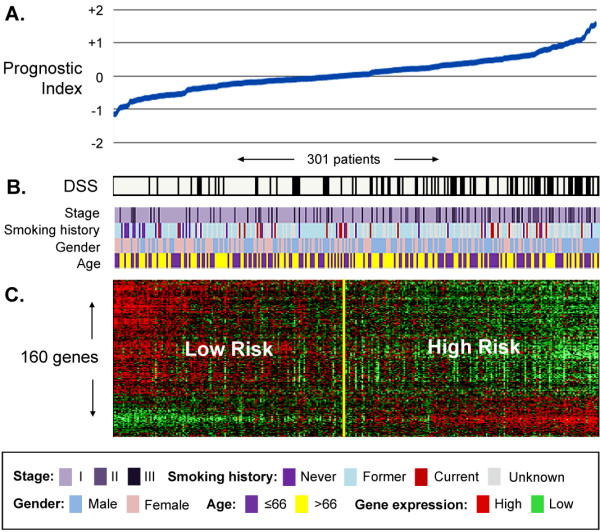
Association between the 160-gene prognostic signature, clinical and survival information in 301 untreated lung adenocarcinoma patients from Training Series A patients with at least 12 months follow-up). (A) Prognostic indexes range from −2 to +2 and are associated with an increase in DSS events, as indicated with a black line at (B). (C) Median-centered 160-gene expression profile used to compute the prognostic index (red = relative high expression, green = relative low expression). Each gene in the signature was chosen based on its statistically significant association with outcome, independent to age, stage, grade, gender and smoking history.